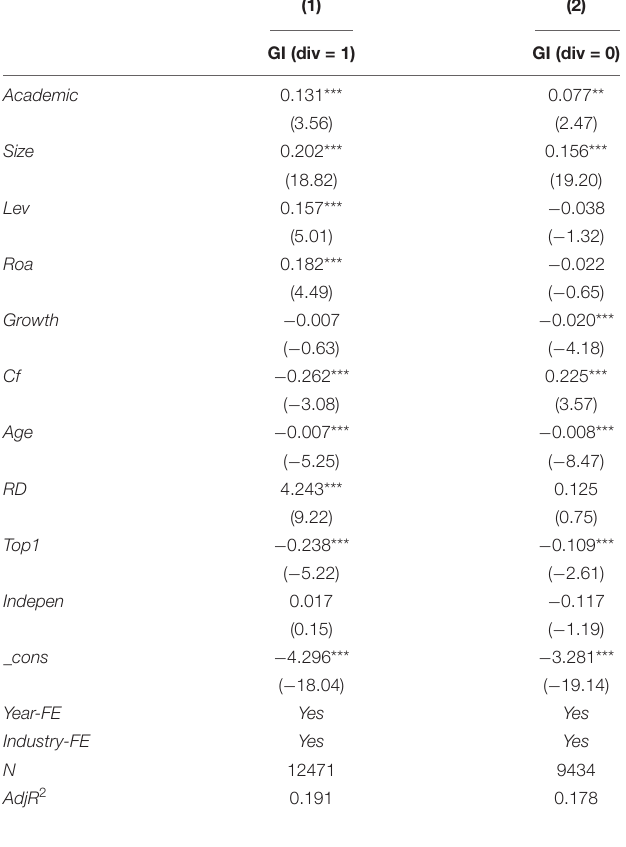
TABLE 9 | Mechanism test results (comprehensive ability).